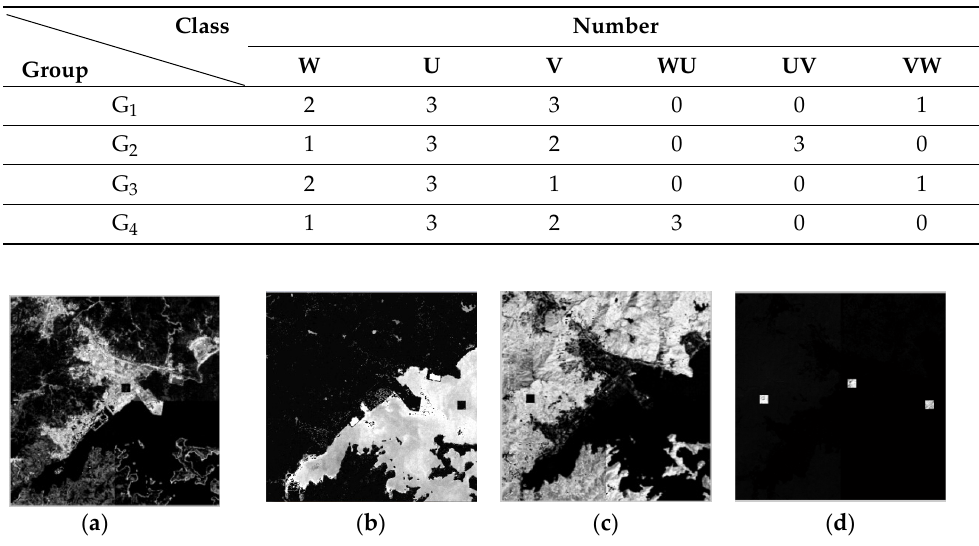
Table 2. The possible endmember spectral numbers in each group.